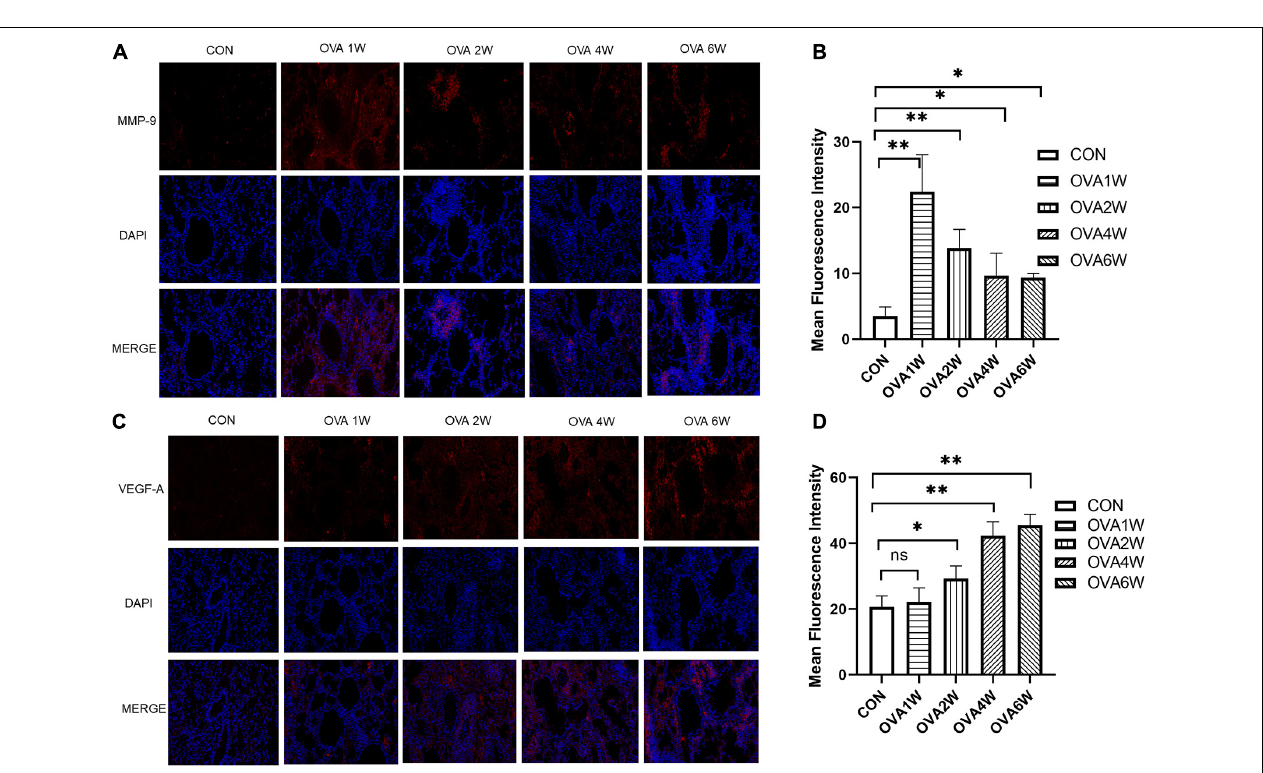
FIGURE 8 | Expression of MMP-9 and VEGF-A proteins in lung tissues. (A) Immunofluorescent staining of MMP-9 (200 × , red: MMP-9; blue: DAPI). (B) Mean fluorescence intensity of MMP-9. Each bar represents the mean ± SD ( n = 6, * P ≤ 0.05 vs the control group; ** P ≤ 0.01 vs the control group). (C) Immunofluorescent staining of VEGF-A (200 × , red: VEGF-A; blue: DAPI). (D) Mean fluorescence intensity of VEGF-A. Each bar represents the mean ± SD ( n = 6, * P ≤ 0.05 vs the control group; ** P ≤ 0.01 vs the control group; ns: no difference).